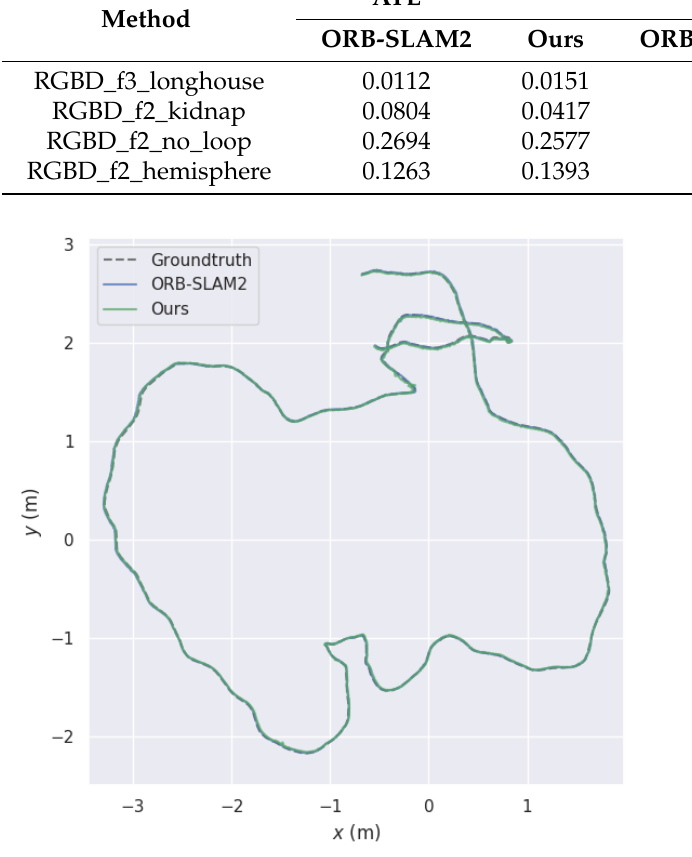
Figure 6. The comparison of the trajectories for the ground truth, ORB-SLAM2, and our method on dataset